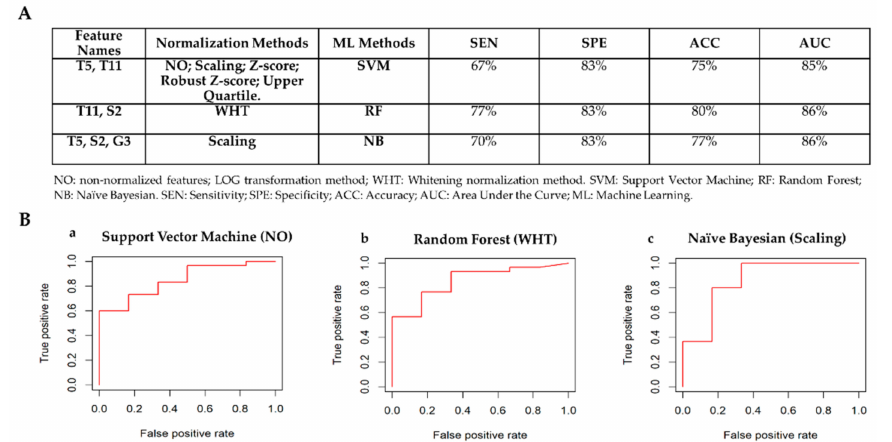
Figure 6. Classifiers’ performance to detect ER receptor status. ( A ) Comparison table among classifiers: ER + vs ER–. ( B ) ROC curves for the best classifiers to automatically detect ER receptor status. a) Best classifier for Support Vector Machine Method. The normalization methods that achieved the best performance are Scaling, Z-score, Robust Z-score, Upper Quartile normalization methods. They achieved the same performance; therefore, one ROC curve with non-normalized features is reported. b) Best classifier for Random Forest Method. The normalization method that achieved the best performance is the whitening method. c) Best classifier for Naïve Bayesian Method. The normalization method that achieved the best performance is scaling